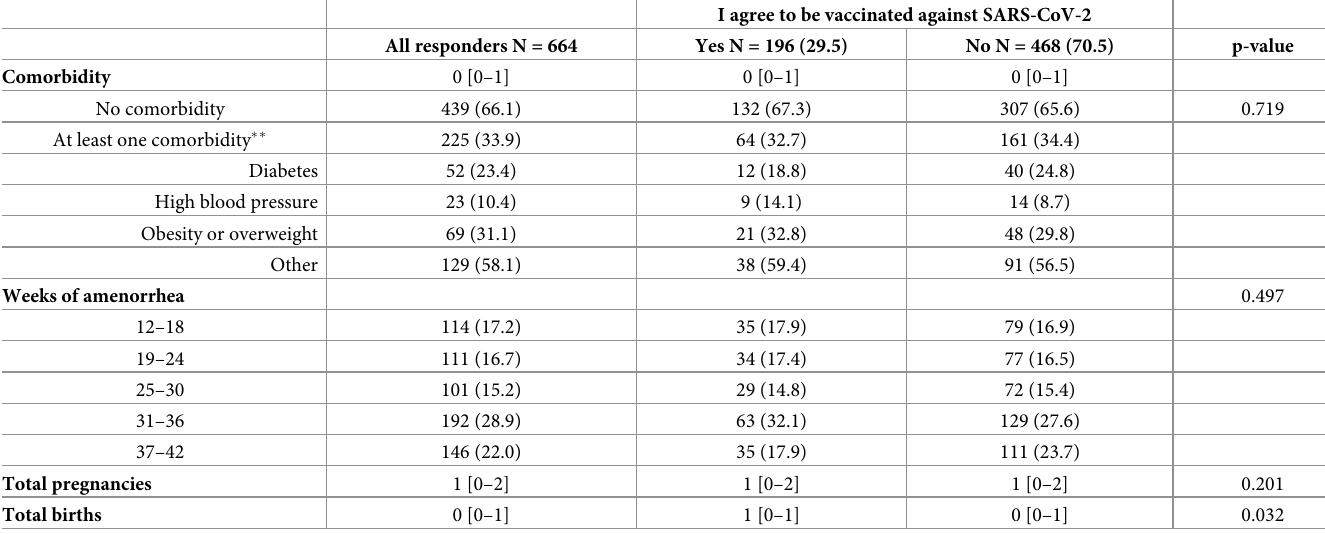
Table 2. Pregnancy characteristics and perceptions of the SARS-CoV-2 vaccine.